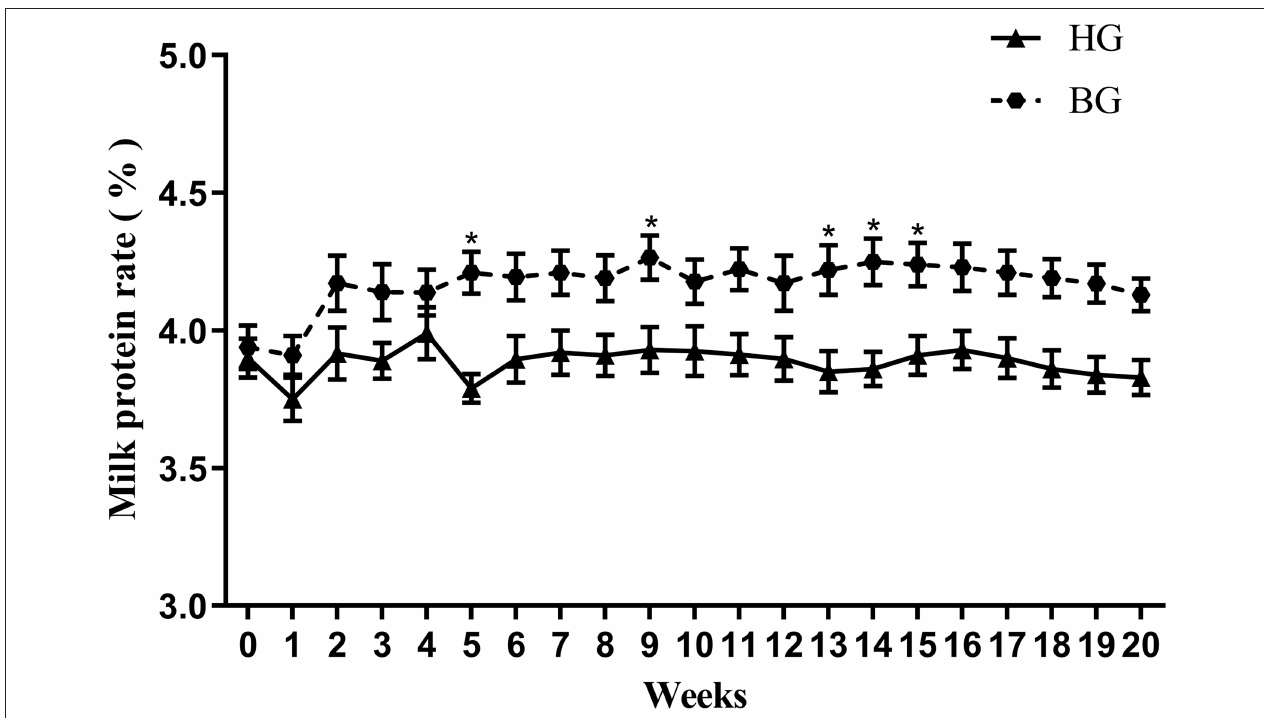
FIGURE 1 | Effect of buffering agents on milk protein rate of lactating goats. Values are mean ± SEM, n = 6/group. * p < 0.05, compared with high grain group.